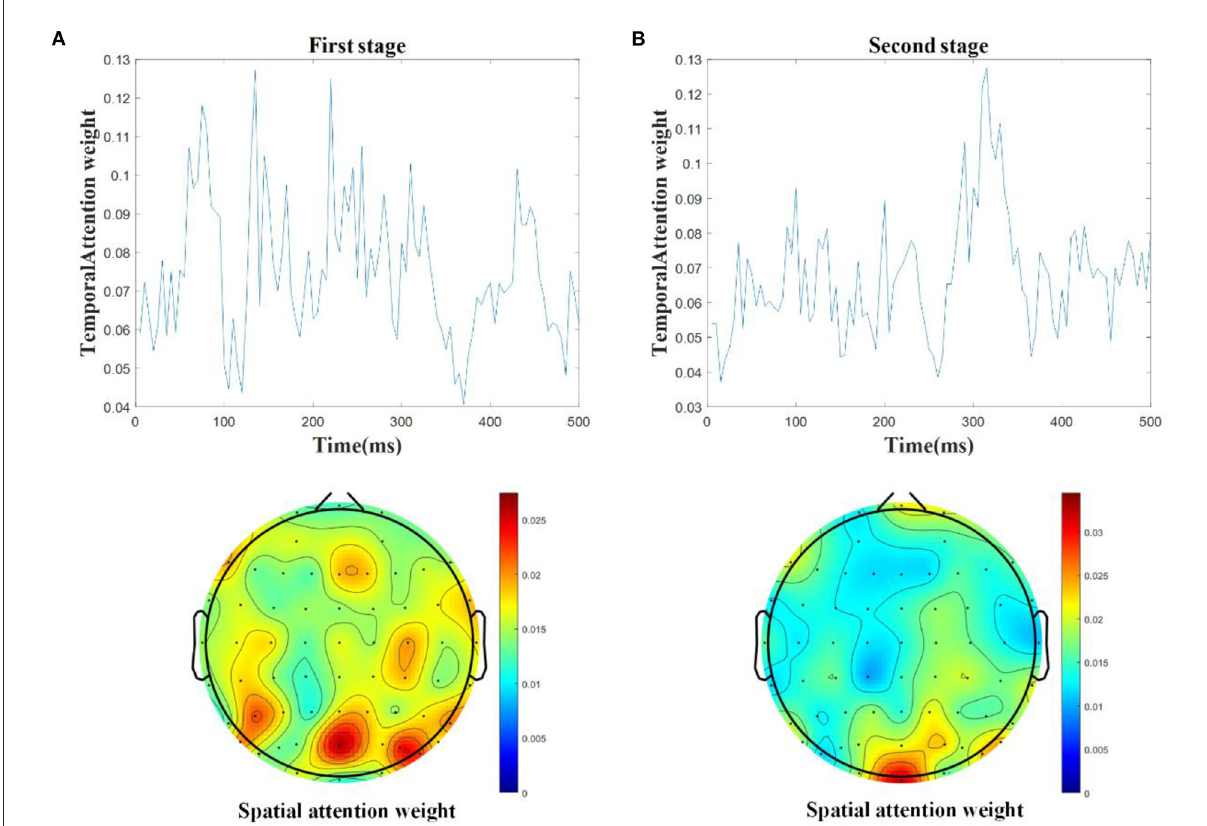
FIGURE5 The average weights of temporal and spatial attention from the test samples based on STA-CNN using line charts and topographies in the first stage (A) and the second stage (B)